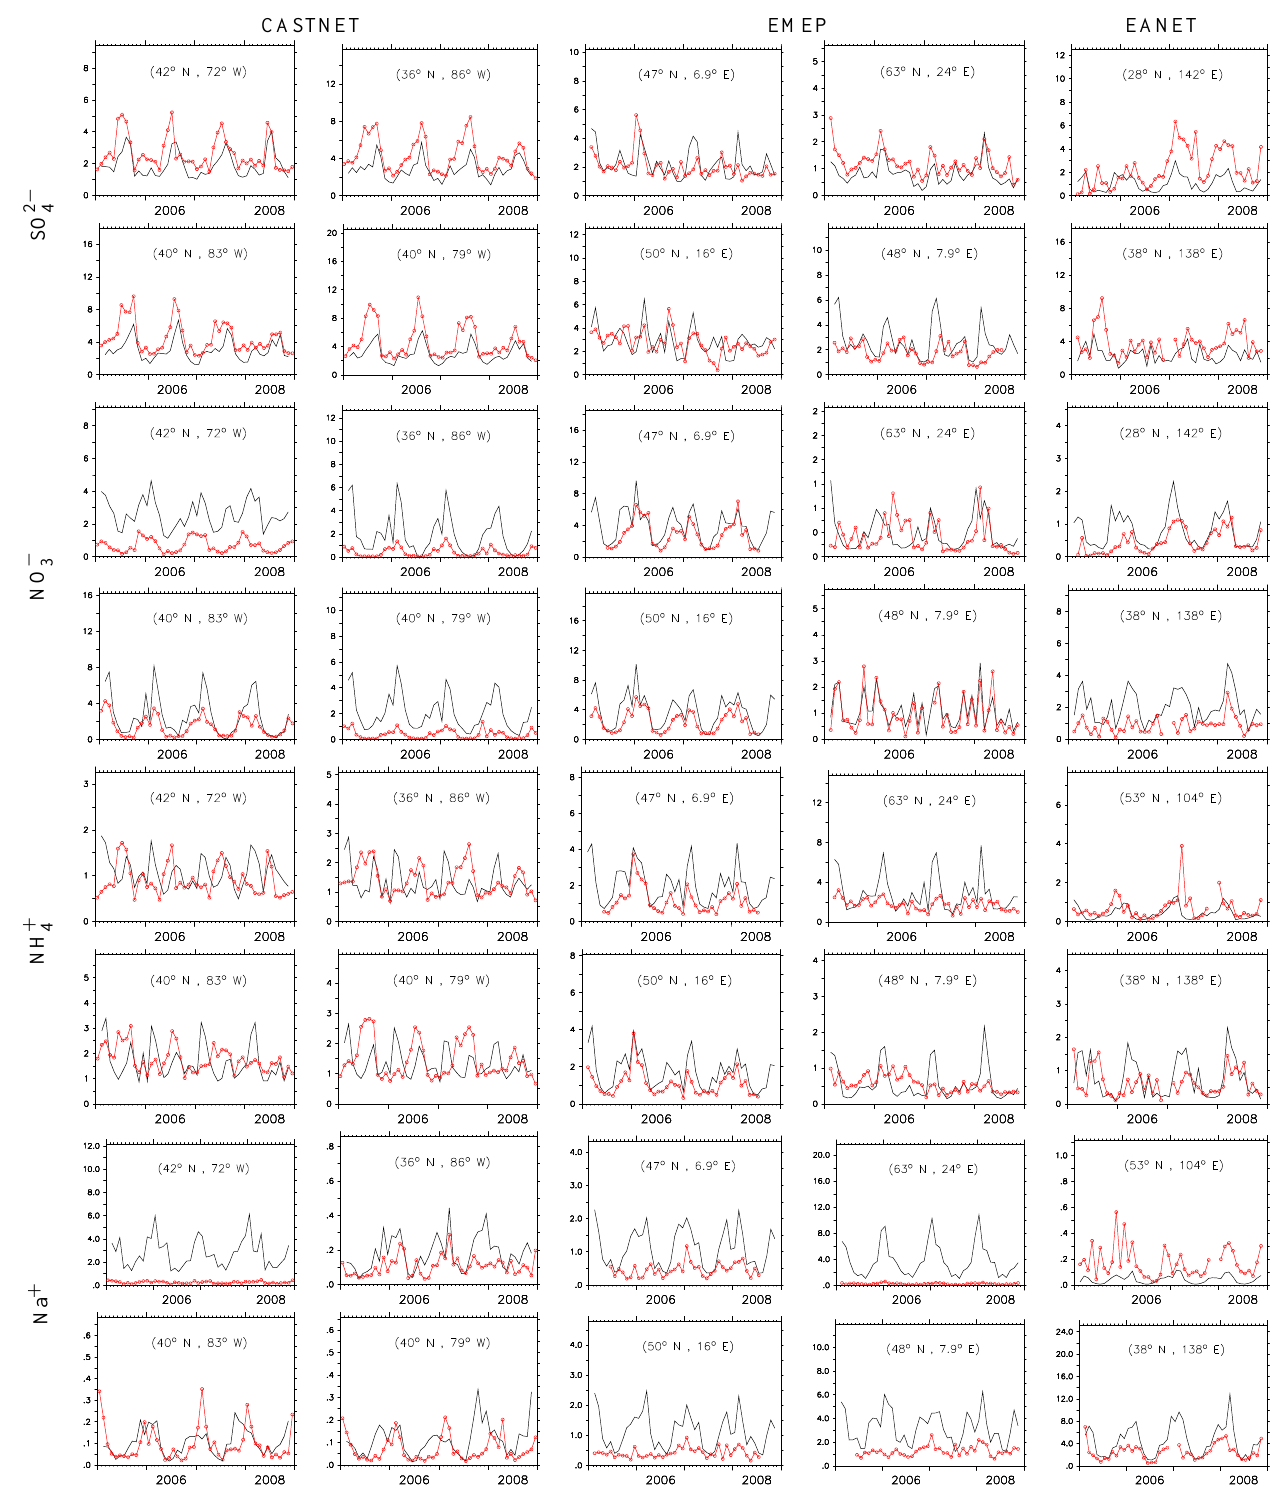
Fig. 4. Comparison of simulated and observed SO 2 − lines represent the observations, while the simulated monthly averages are indicated by the black lines. The location of the stations (longitude and latitude) is at the center of each plot. Note the different scales of the vertical